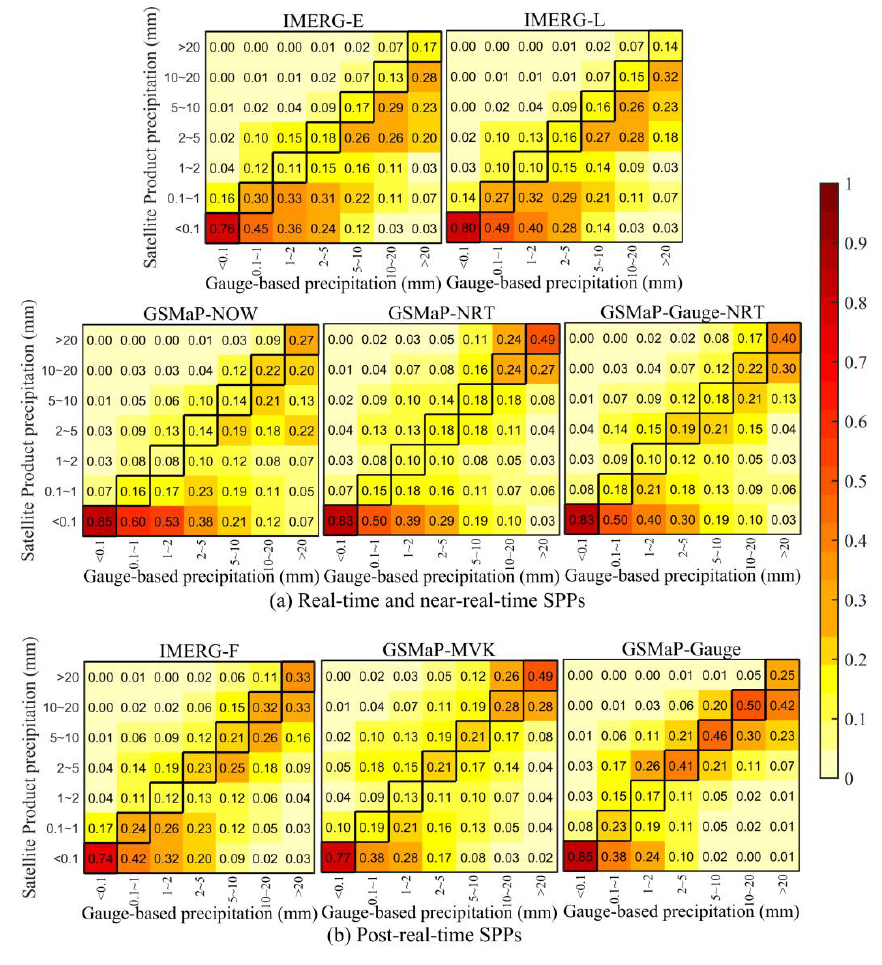
Figure 10. Confusion matrix of daily precipitation from the gauge-based precipitation and eight SPPs: ( a ) Real-time and near-real-time SPPs and ( b ) Post-real-time SPPs.